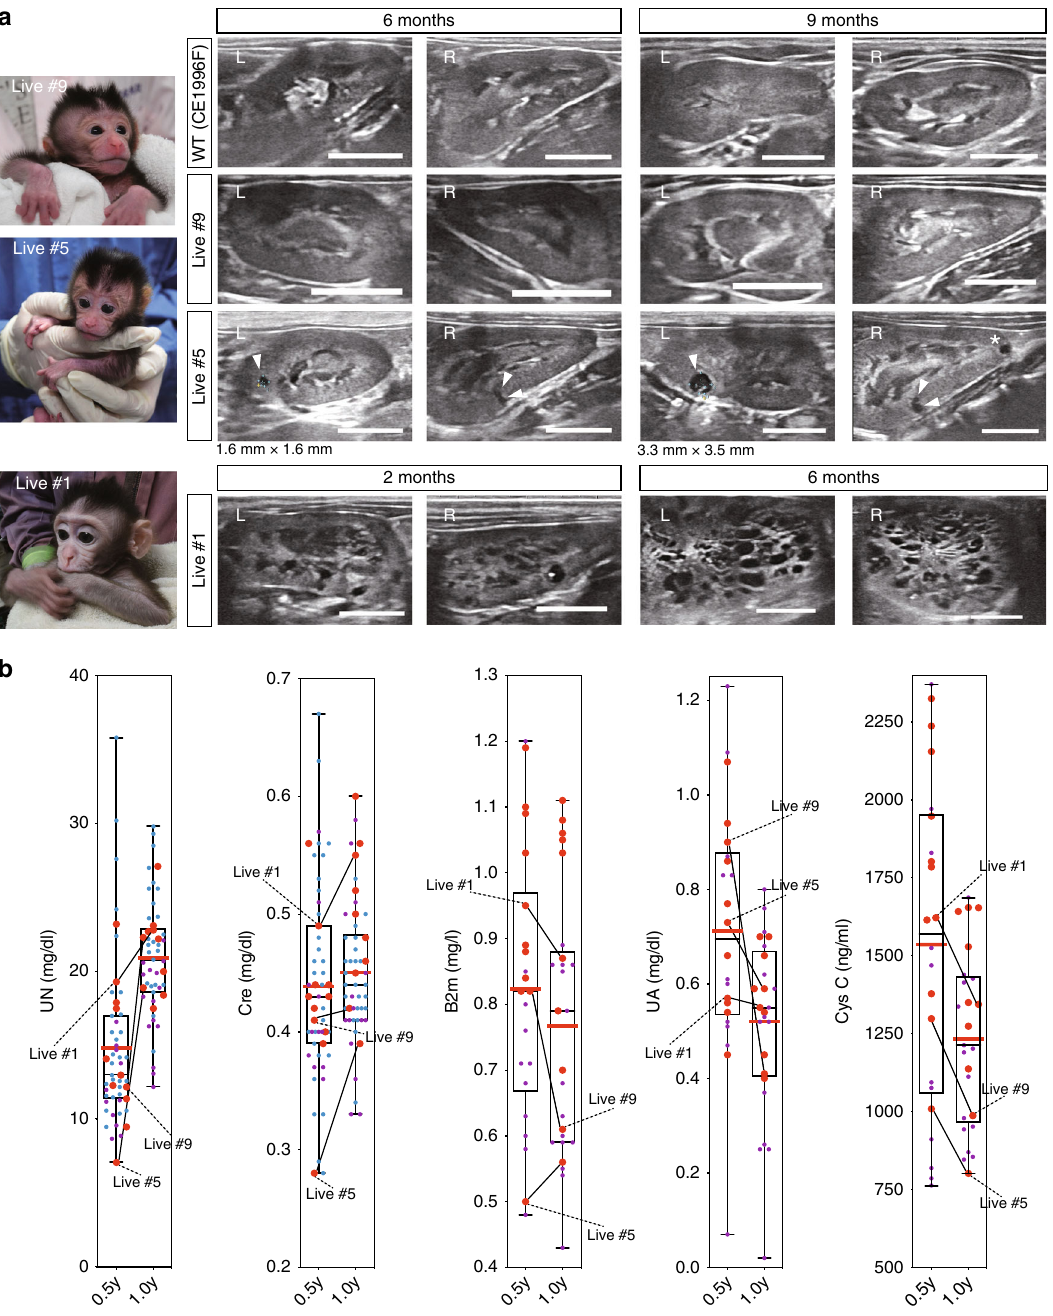
Fig. 5 PKD1 -mutated monkeys with numerous cysts can survive. a Cyst formation detected by ultrasonography in live monkeys. Arrowheads indicate cyst formation. Scale bar, 10 mm. b Box plot of renal function of each monkey at 6 and 12 months after birth. “ UN ” indicates urea nitrogen, “ Cre ” indicates creatinine, “ B2m ” indicates beta2-microglobulin, “ UA ” indicates uric acid, and “ Cys C ” indicates cystatin C. Large red dots indicate mutated monkeys. Small purple dots indicate wild-type monkeys grown at Shiga University of Medical Science. Small blue dots indicate wild-type monkeys grown at Shin Nippon Biomedical Laboratories. The top and bottom edges of boxes indicate the fi rst and third quartiles, respectively; the center lines indicate the medians; and the ends of whiskers indicate the maximum and minimum values, respectively. Red lines indicate the average. Source data are provided as a Source Data fi le. n = 55